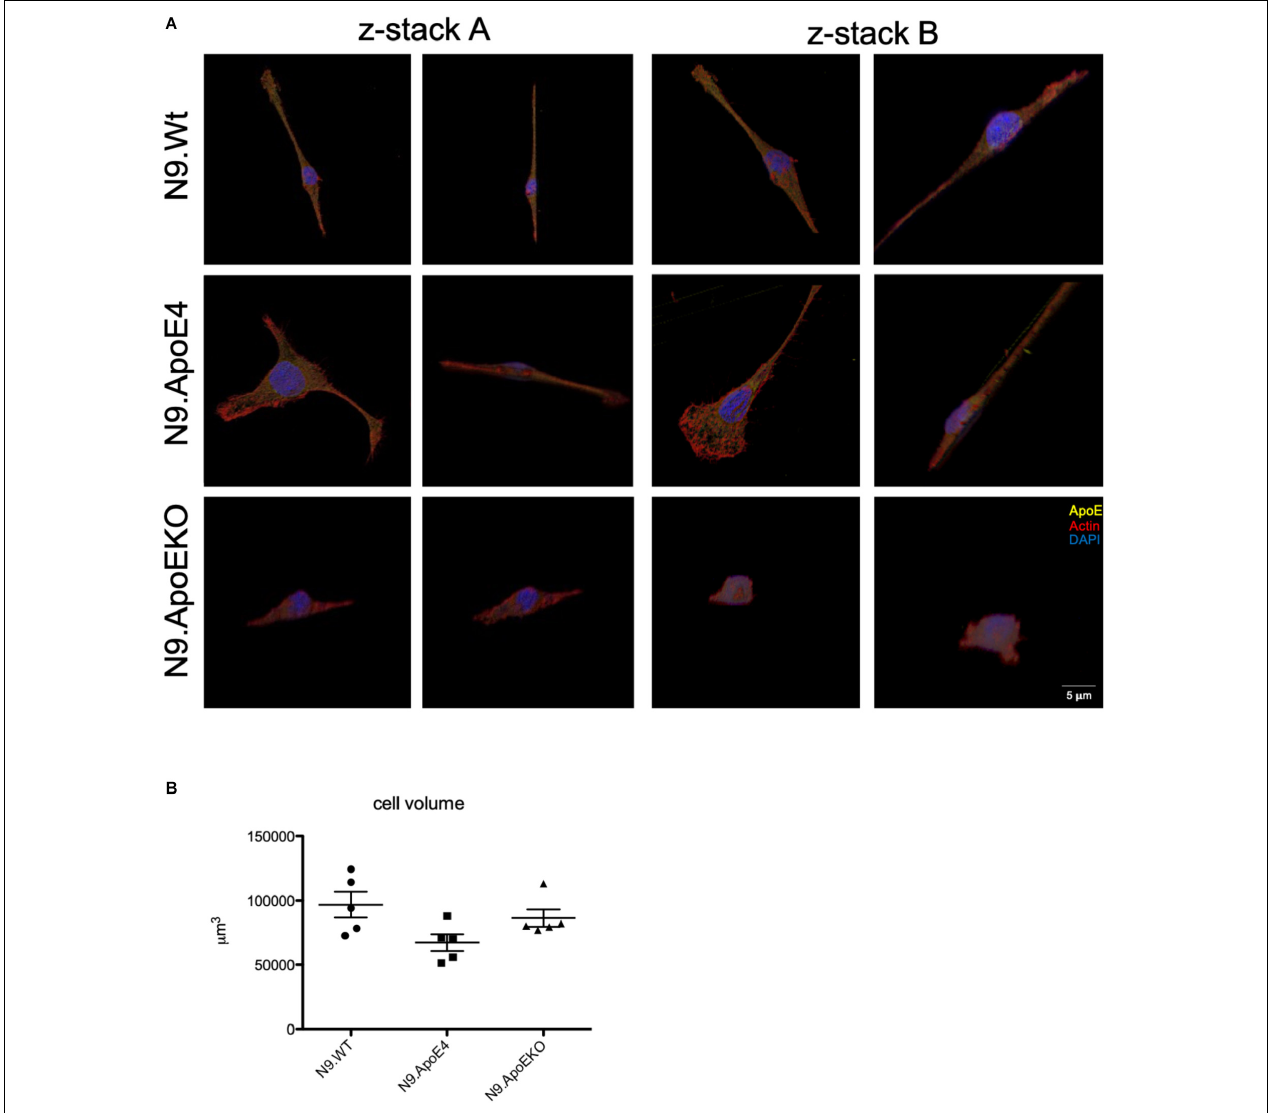
FIGURE 2 | 3D-reconstruction of z-stack images display discoidal morphology of N9.ApoE4 cells. (A) Two representative z-stack images from N9.Wt, N9.ApoE4, and N9.ApoEKO were reconstructed with IMARIS × 64 software. N9.ApoE4 show a more discoidal cell form in comparison to N9.Wt and N9.ApoEKO. In addition, N9.ApoE4 have distinct actin stress fibers ( n = 5). (B) Quantification of cell volume demonstrate no significant differences in N9.ApoE4 and N9.ApoEKO in comparison to N9.Wt ( n =